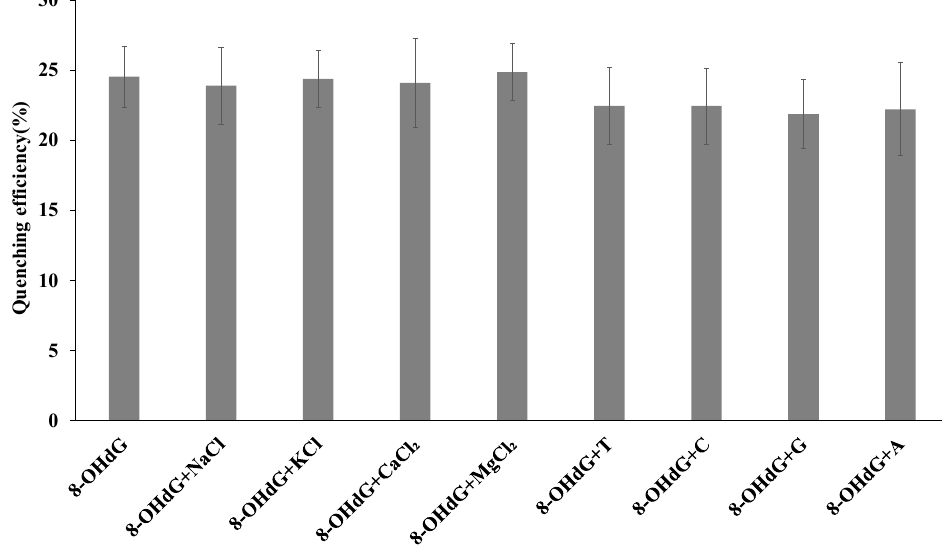
Figure 5. Detection of 8-OHdG in the presence of interference NaCl, KCl, CaCl 2 , MgCl 2 , thymine, cytosine, guanine, and adenine.